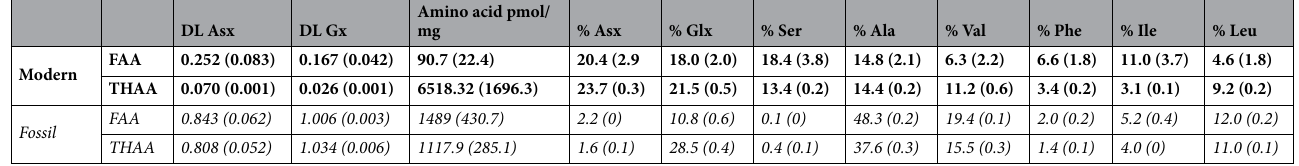
Table 1. Amino acid racemization and relative abundance in modern Phycis phycis (bold fields) and fossil P. tenuis (italic fields) otoliths. Note the decrease in % Asx and pmol THAA/mg starting otolith powder and increase in % Ala of fossil relative to modern otoliths. Average of replicates are shown with standard deviations in parentheses; technical duplicates of each from three modern and one fossil specimen were analyzed.